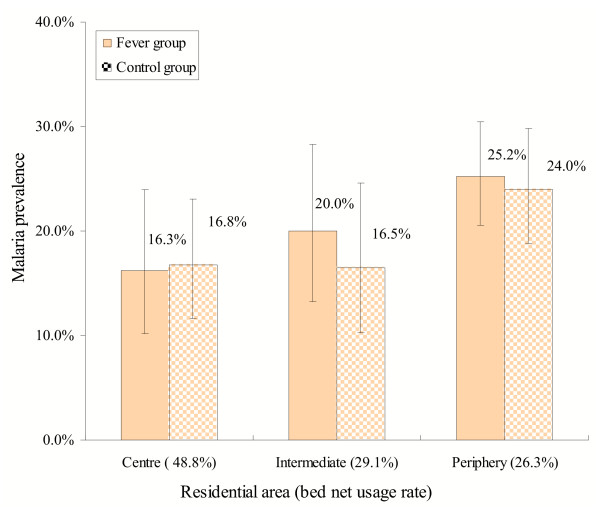
Malaria prevalence in fever cases and control groups by residential areas of patients. Health facility-based surveys. Vertical bars represent 95% CI.